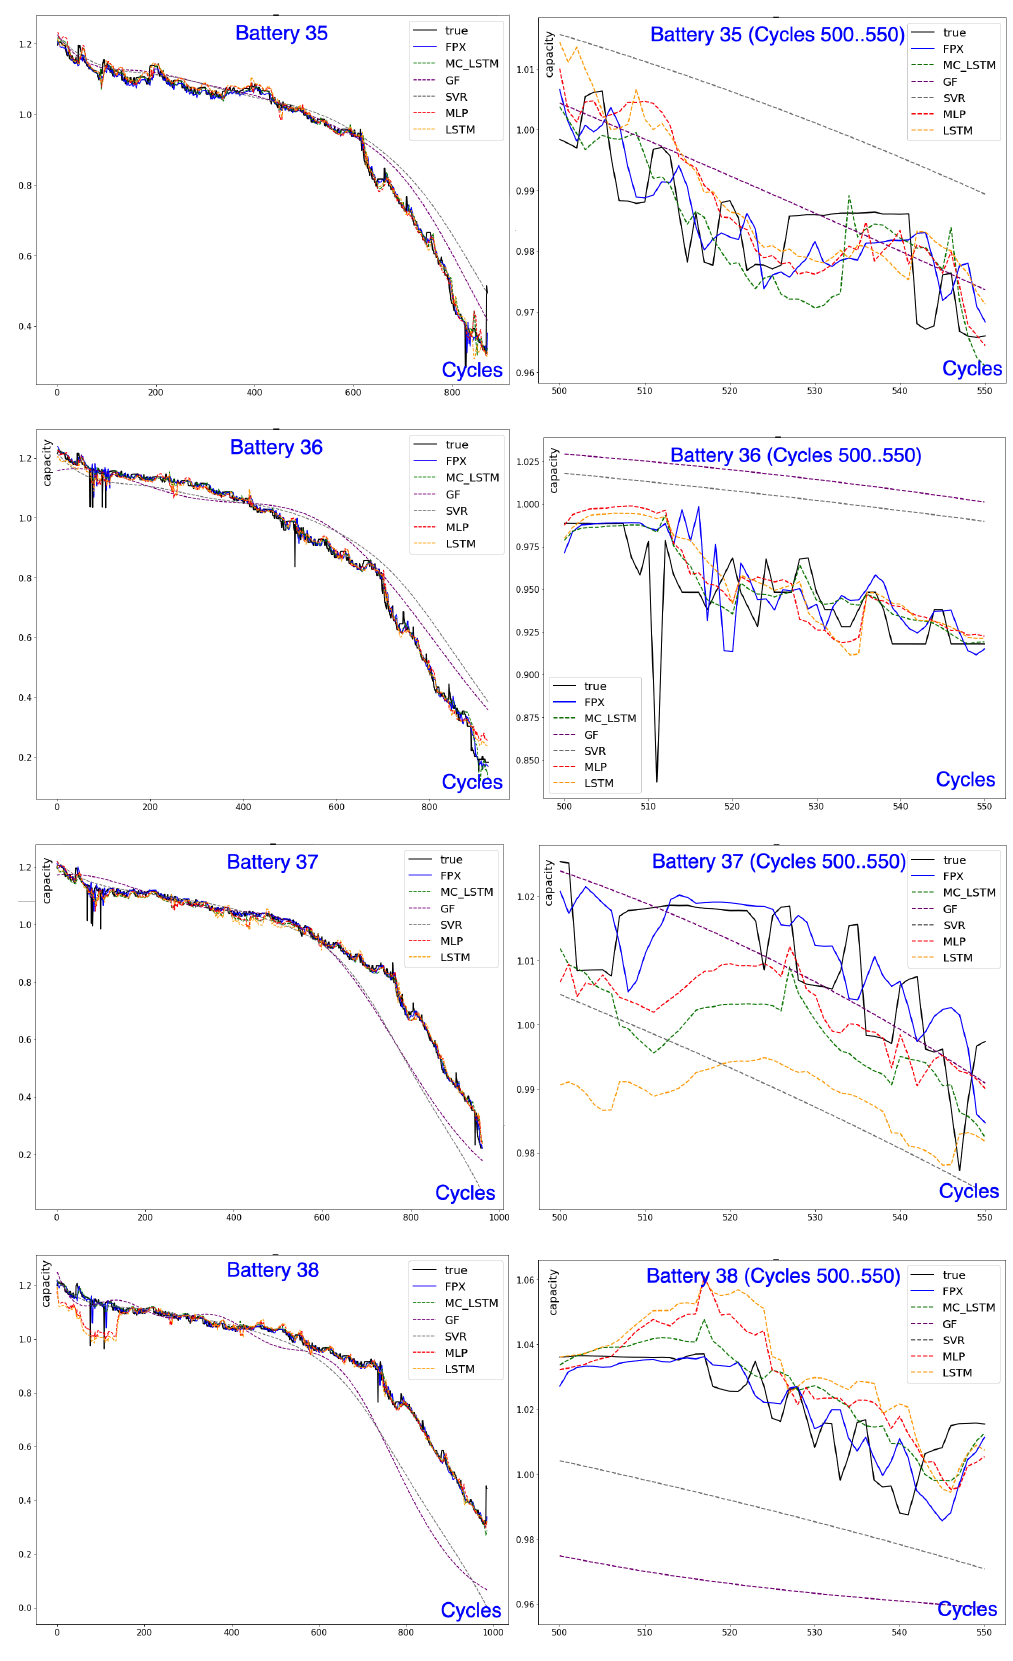
Figure 13. Accuracy comparison with different methods using CALCE